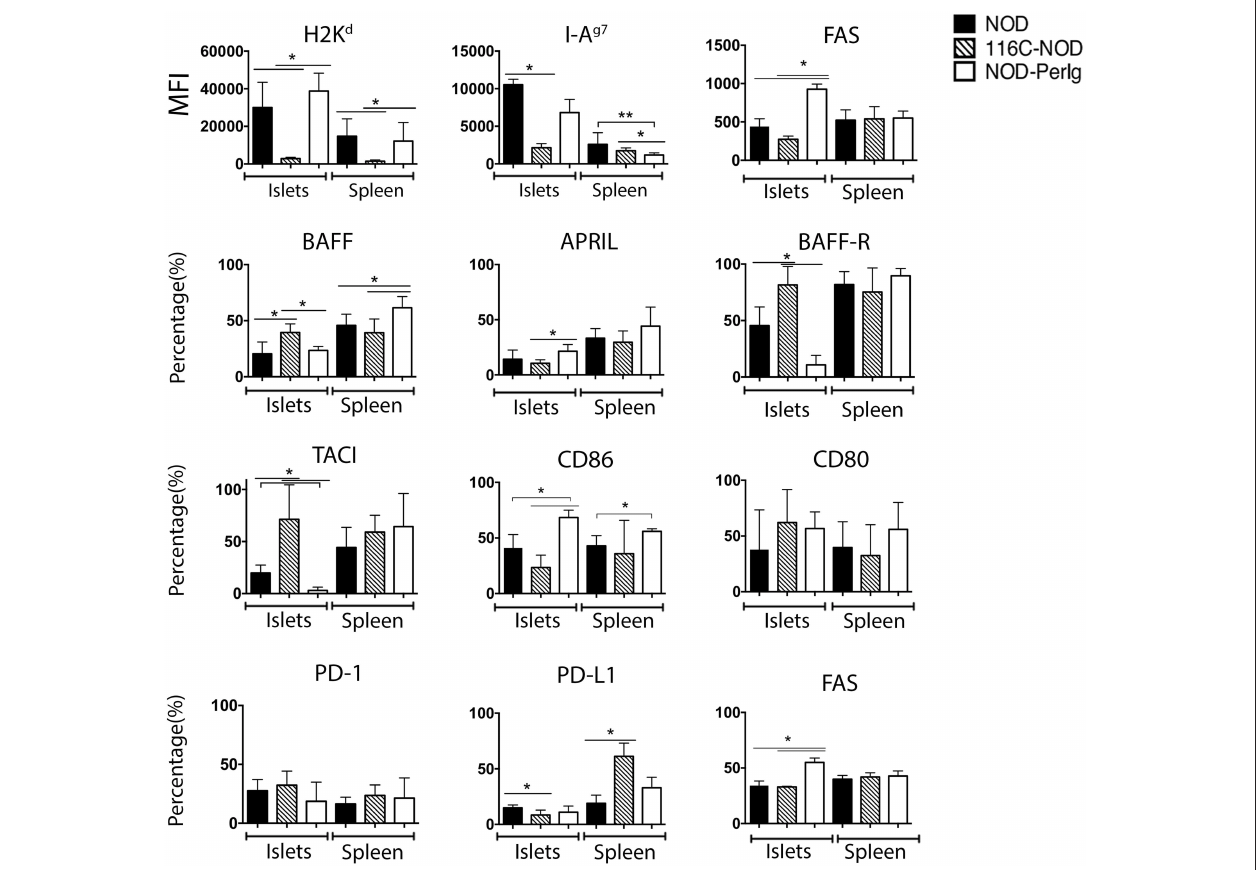
FIGURE 1 | Expression of MHC, costimulatory and coinhibitory molecules in B-lymphocyte membrane. Median fluorescent intensity (MFI) of H2K d , I-Ag 7 , and FAS expression, and percentage values of BAFF, APRIL, BAFF-R, TACI, CD86, CD80, PD-1, PD-L1, and FAS positive islet-infiltrating or splenic B-lymphocytes from 6-week-old NOD, 116C-NOD and NOD- PerIg were analyzed ( N = 5 per group, with two replicates for each experimental condition). Bars show the SD of the median of MFI or from the percentage values. Mann-Whitney U was used for analysis and statistically significant differences are shown as * P < 0.05 or ** P < 0.01.